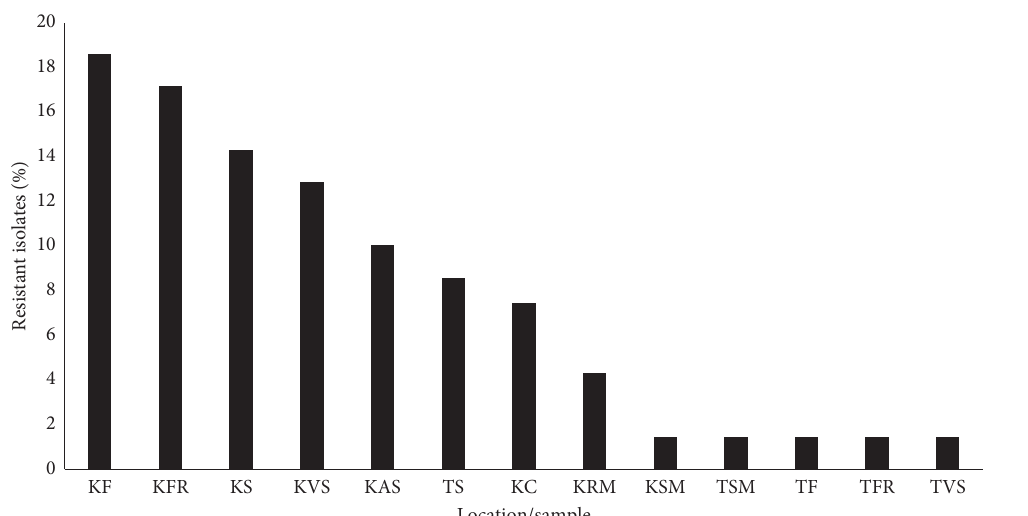
Figure 3: Proportion of antibiotic-resistant bacteria from food vended in Embu Town and Kangaru Market. KAS, Kangaru African sausage;